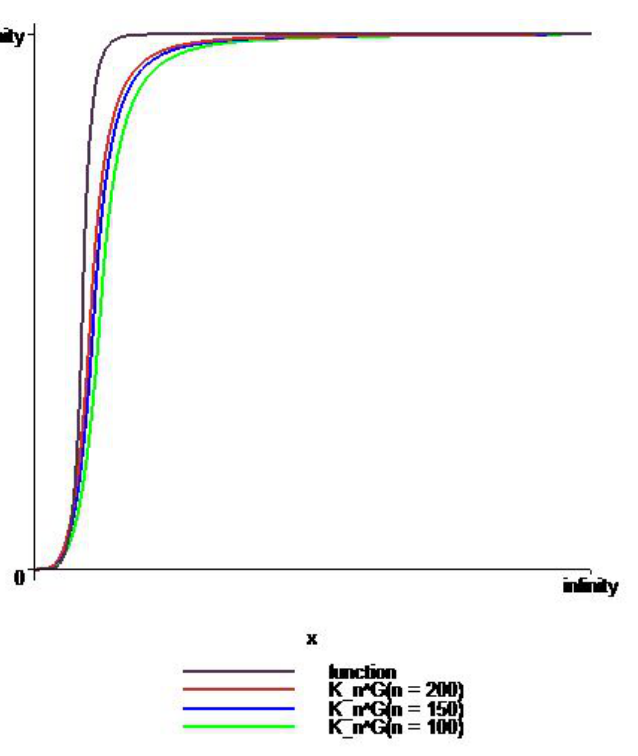
Figure 1. Approximation by K G (violet) on [ 0, ∞ ) for ρ n = n − 1/20 , such that τ n = n ρ n , i.e., τ n = n 19/20 and β n = 1 − 50 n − 1 .